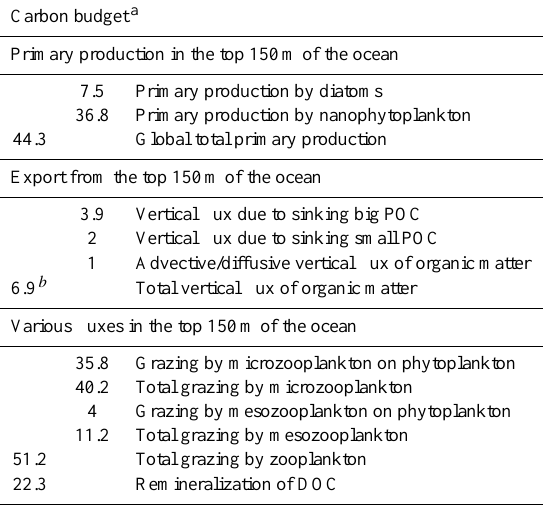
Table 4. Global annual budget of C in the top 150m of the ocean. Carbon budget